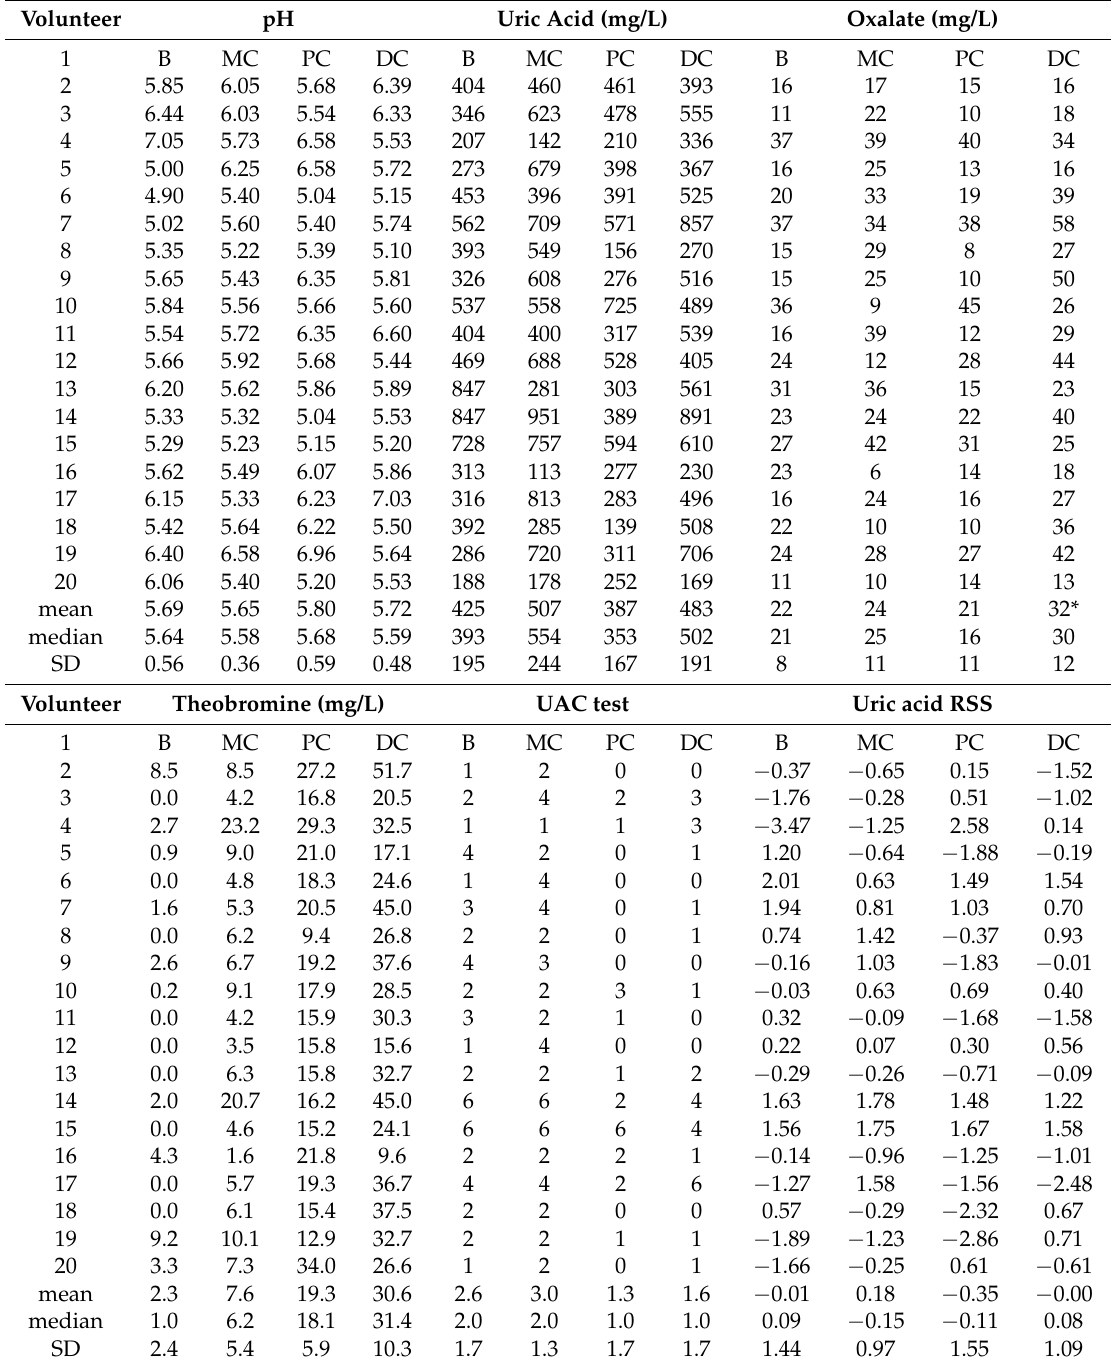
Table 1. Individual volunteer ( n = 20) data, mean, median and standard deviation (SD) of urinary parameters (pH, uric acid, oxalate, theobromine, UAC test and uric acid relative supersaturation (RSS) [26]) for basal conditions and under cocoa derived products nutritional